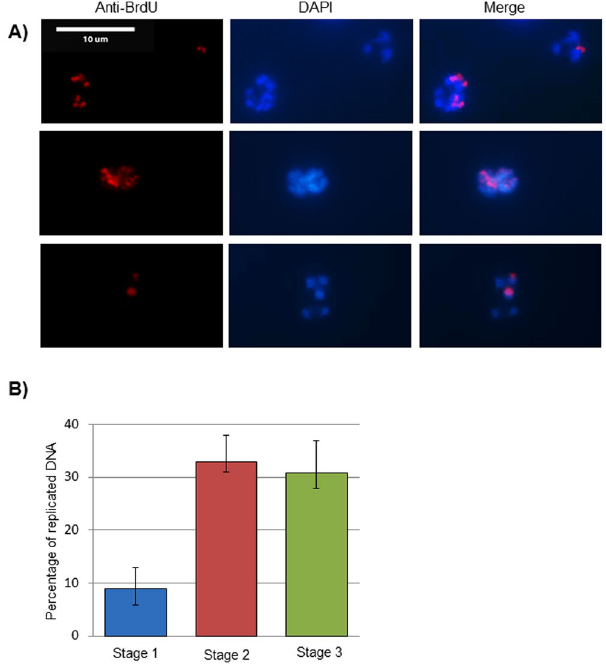
Figure 5. The amount of actively replicating DNA increases during schizogony. ( A ) Example immunofluorescence pictures of parasites exposed to 100 μ M BrdU for 30 minutes, then labelled with DAPI (blue, all DNA) and an anti-BrdU antibody (red, newly-replicated DNA). ( B ) Percentage of actively replicating DNA during the 20-minute pulse-labelling period in synchronous blood-stage parasites at Stages 1–3. Mean percentages from three technical replicates are shown; in each replicate ~25 Mb of DNA fibres were analysed. Error bars show the range (minimum to maximum) across the three replicates. Images of combed DNA fibres were acquired randomly and the percentage of IdU + CldU tracks was calculated over the total DNA fibres length in all images (P = 0.0006 with one-way ANOVA analysis of variance; Stage 1 differs significantly from Stages 2 and 3 by T-test but Stages 2 and 3 do not